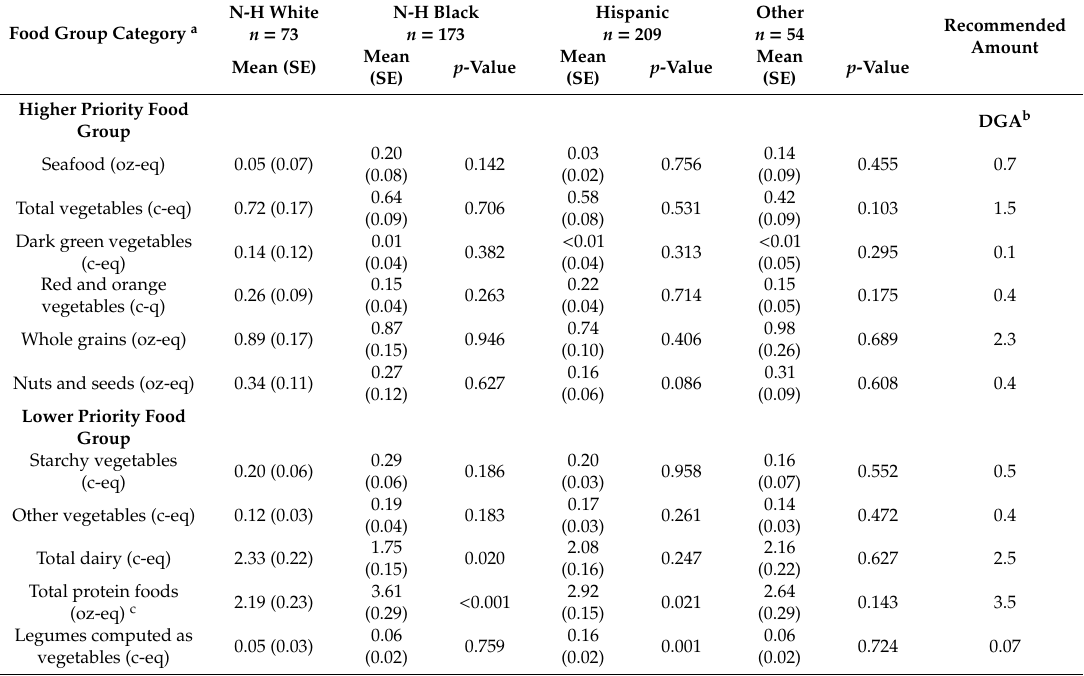
Table 3. Racial / ethnic di ff erences in food group intake of WIC-participating children 2–4 years of age in the NHANES 2011–2014 ( N =